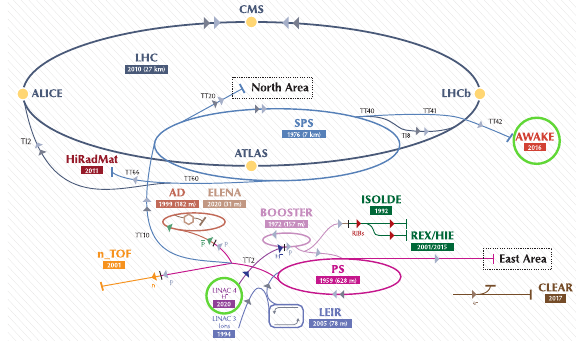
FIG. 1. The CERN accelerator complex. Reinforcement learn- ing agents were used on the accelerators highlighted with green circles.